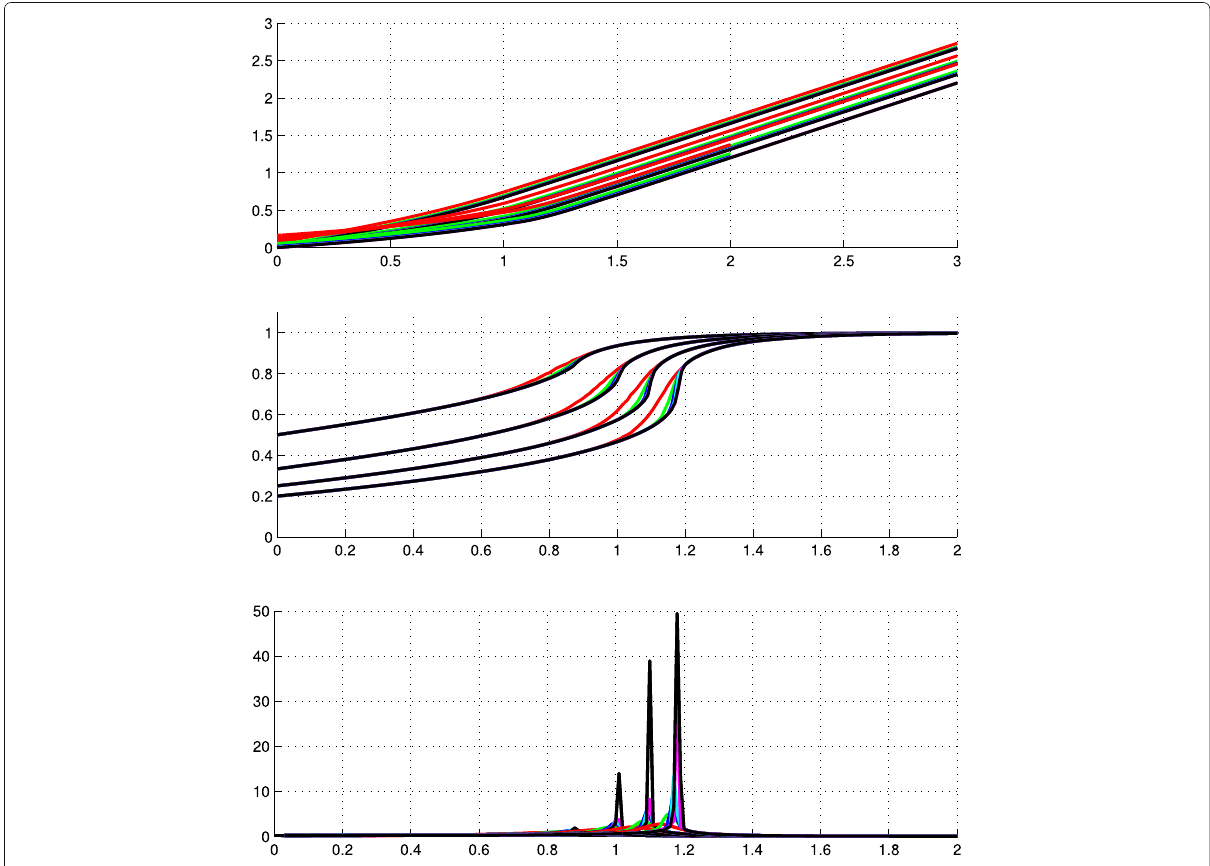
Fig. 8 From to to bottom: Log-partition ¯ Z (β) , its first and second derivatives as a function of β (from β = 0 to β = 3) for various sizes of image ( P = 64,128,256,512 ) and number of class ( K = 2,3,4,5